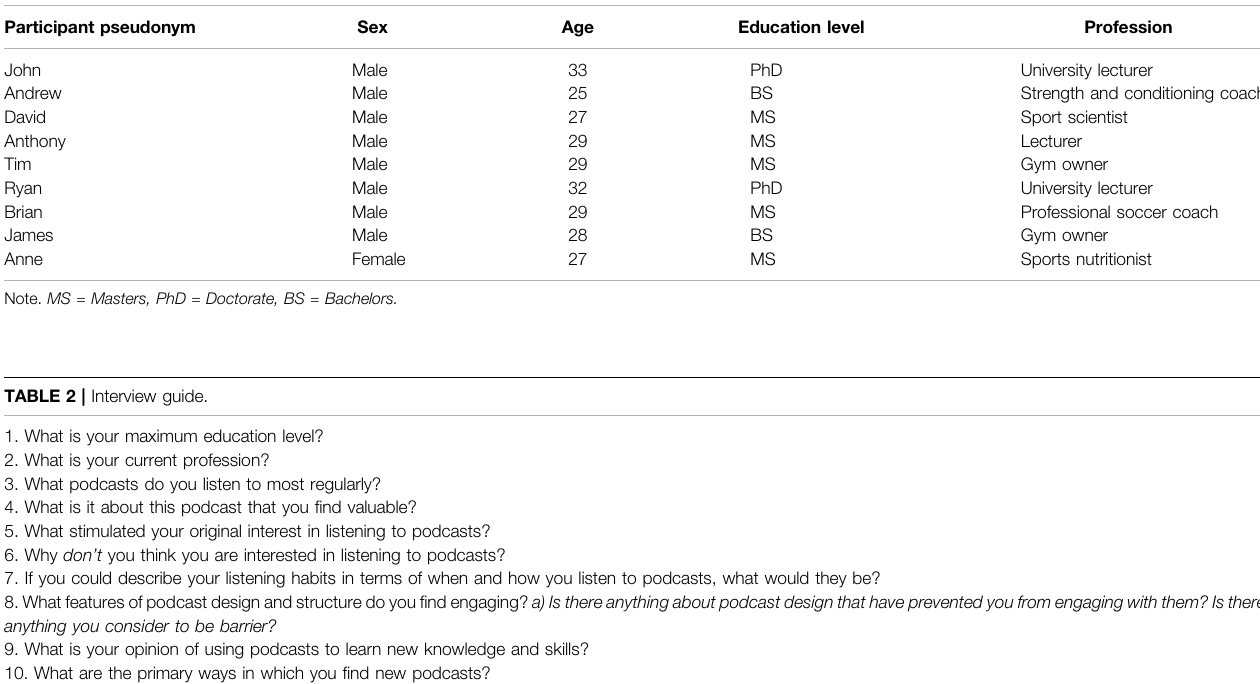
TABLE 1 | Participant